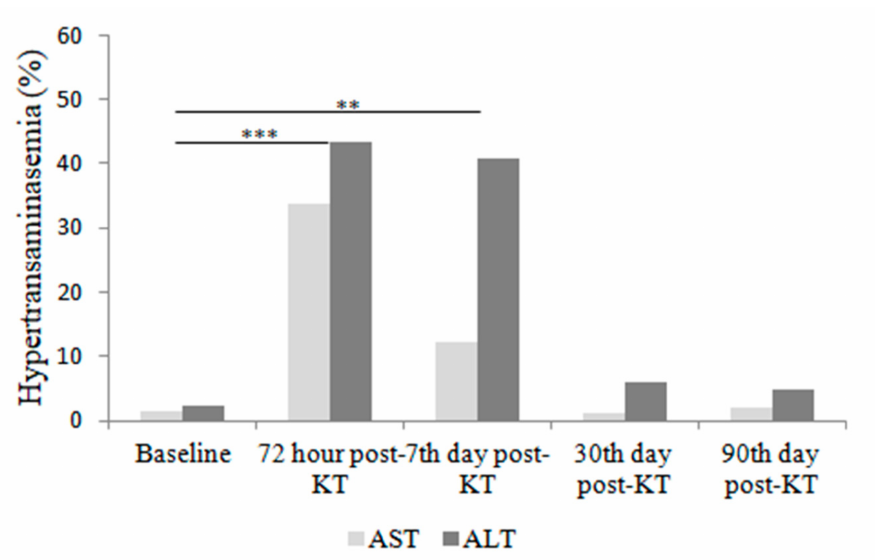
Figure 2. Percentage of patients with elevated transaminases above normal values at different time-points related to transplantation. Comparisons to baseline were made with McNemar test.